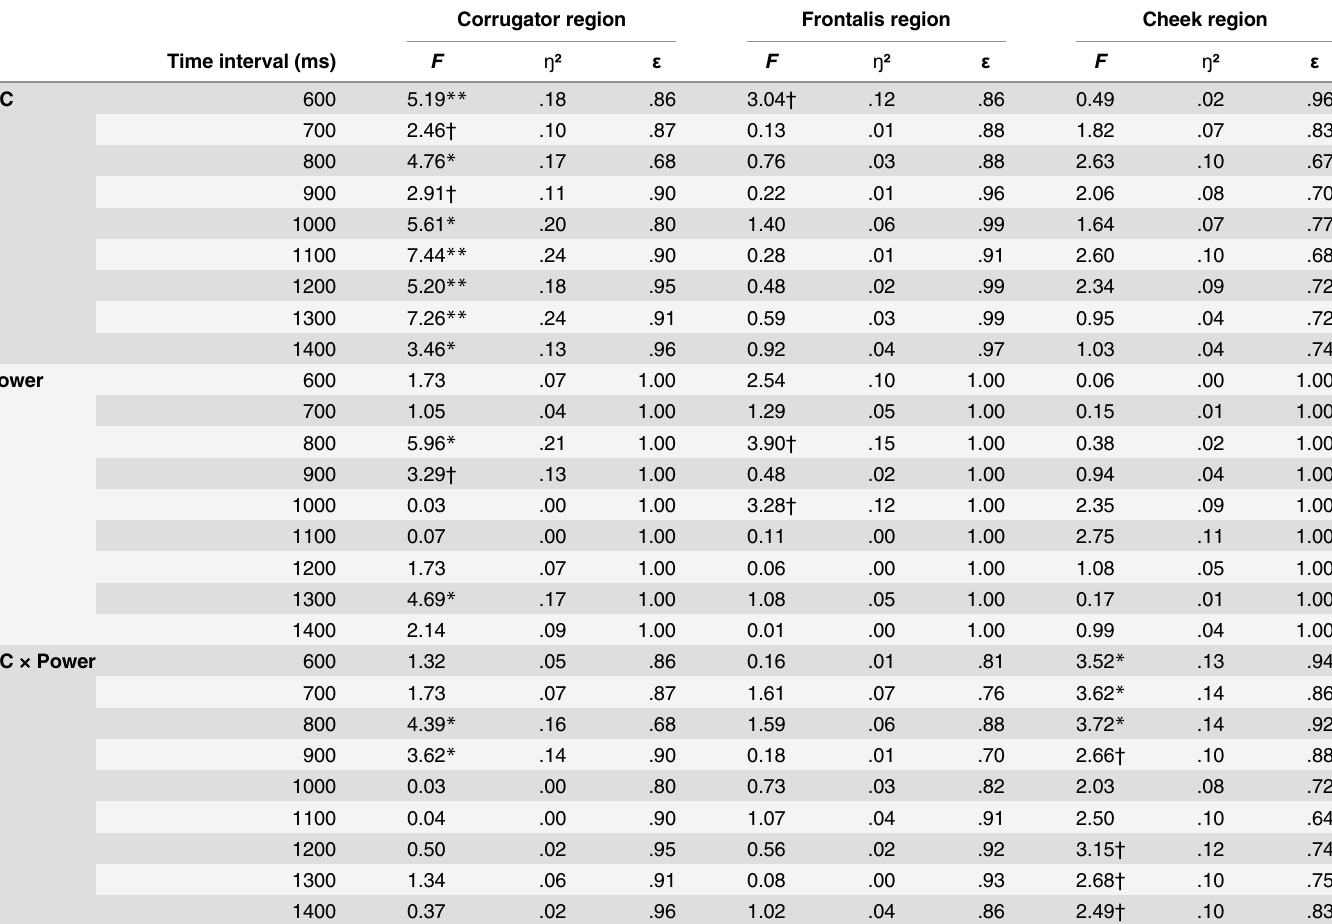
Table 2. Results of the Planned Comparisons for Each Facial